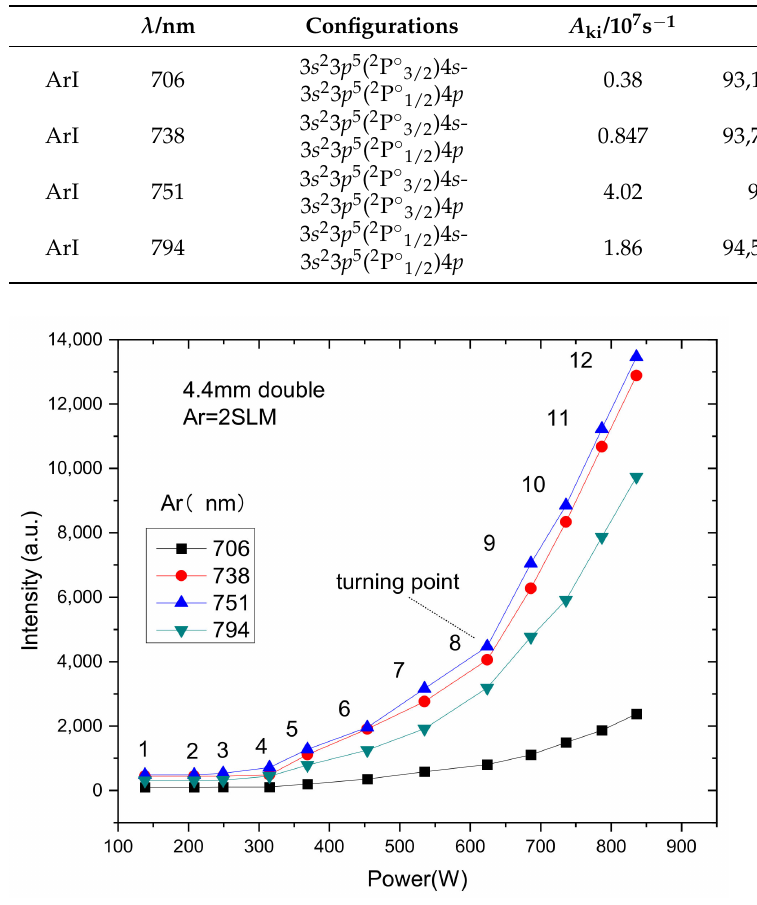
Figure 11. Variation of intensities of each spectral line in Table 1 with power. Variation of intensities of each spectral line in Table 1 with power are shown in Figure 11. The first 8 points of each line (138–624 W) represent discharge in α mode, and the last 4 points (686–836 W) represent discharge in γ mode. It can be seen that